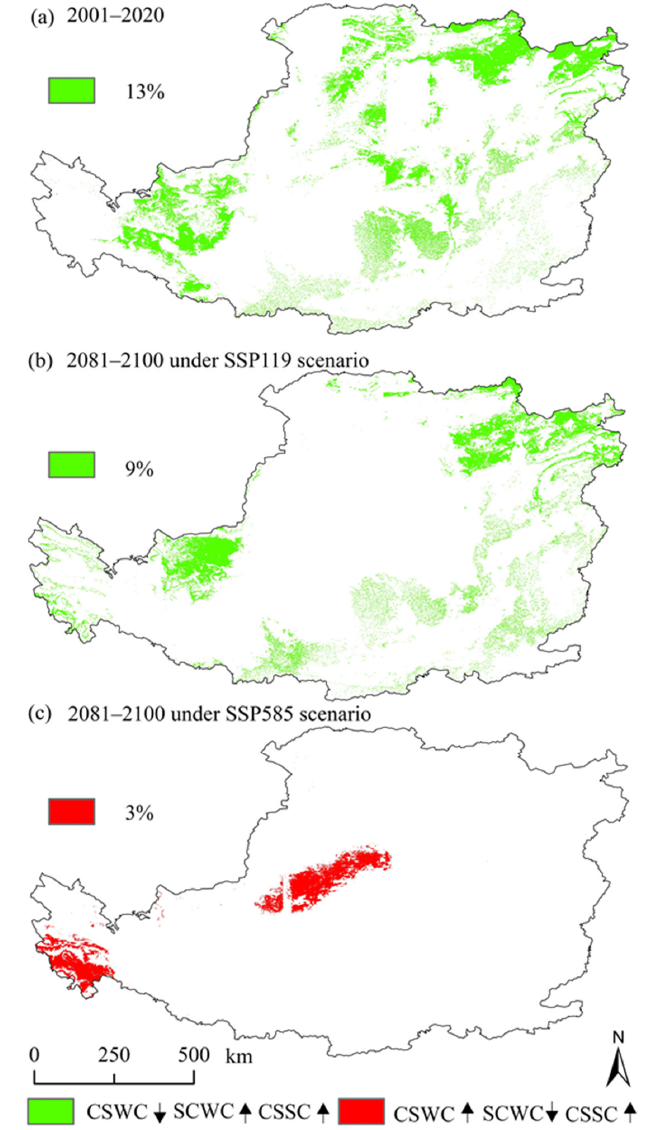
Figure 6. Significant trade-offs and synergistic relationships between the ecological functions of vegetation during 2001–2020 and 2081–2100. Note: carbon stock and water conservation functions, CSWC; soil conservation and water conservation functions, SCWC; carbon stock and soil conservation functions, CSSC; ↑ significant synergism; ↓ significant trade-off. ( a ): the significant trade-offs and synergistic relationship between the CSWC, SCWC, and CSSC during 2001–2020; ( b ): the significant trade-offs and synergistic relationship between the CSWC, SCWC, and CSSC during 2081–2100 under SSP119 scenario; ( c ): the significant trade-offs and synergistic relationship between the CSWC, SCWC, and CSSC during 2081–2100 under SSP585